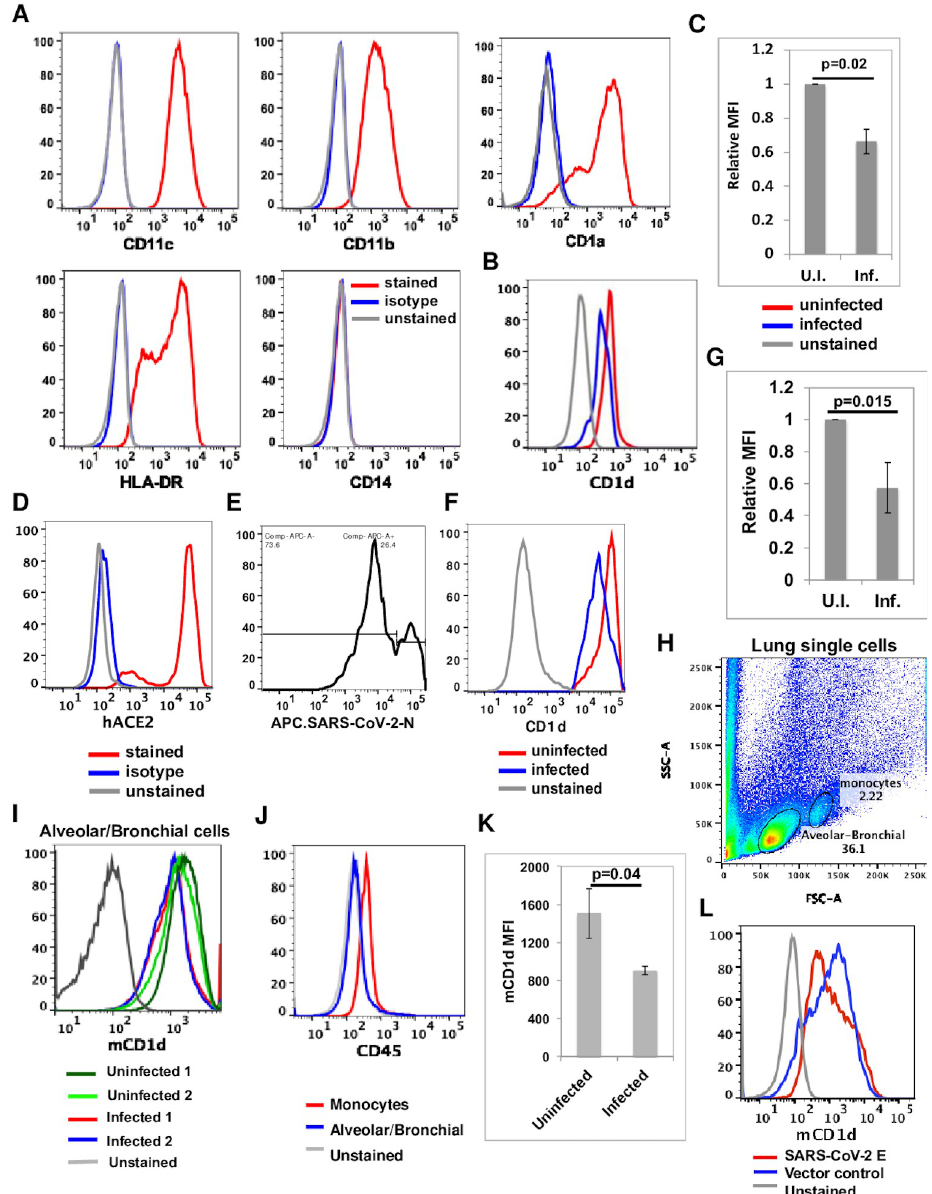
Fig 2. SARS-CoV-2 infection downregulates CD1d in antigen-presenting cells. (A-C). Human peripheral blood monocytes were purified from a healthy donor, derived into dendritic cells, stained with surface markers (A) and infected with SARS-CoV-2 (Isolate USA-WA1/2020) at m.o.i. of 10. At 24 hours post infection, dendritic cells were fixed by paraformaldehyde and stained with anti-CD1d monoclonal antibody CD1d.51.1 then permeabilized and stained with antibodies against viral nucleocapsid (N) protein. Cell surface CD1d expression was compared between infected (N-positive) and uninfected (N-negative) dendritic cells (B, C). (D-G). Sorted HeLa.CD1d.hACE2 cells were stained for expression of human ACE2 protein (D), infected with SARS-CoV-2 (Isolate USA-WA1/2020) at a m.o.i. of 1, fixed and stained for cell surface CD1d and then intracellular N protein as in (E). Cell surface CD1d expression was compared in infected (N protein-positive) and uninfected (N protein-negative) cells (F). Relative CD1d MFI is calculated as CD1d MFI in infected cells divided by CD1d MFI in uninfected cells. Infection experiments were repeated total three times and representative FACS plots are presented. (C.G). Relative CD1d MFI values were calculated and plotted as the mean ± s.d. P values were calculated with two-side unpaired Student’s test. (H-L). SARS-CoV-2 infection downregulates the expression of mouse CD1d. (H-K). hACE2-Tg mice (n = 2) were infected with SARS-CoV-2 (Isolate USA-WA1/2020, 1X10e4 pfu per mouse). Single cells were prepared from mouse lungs three days post infection and blocked with anti-CD16/CD32 antibodies before being stained for anti-CD45 (J)